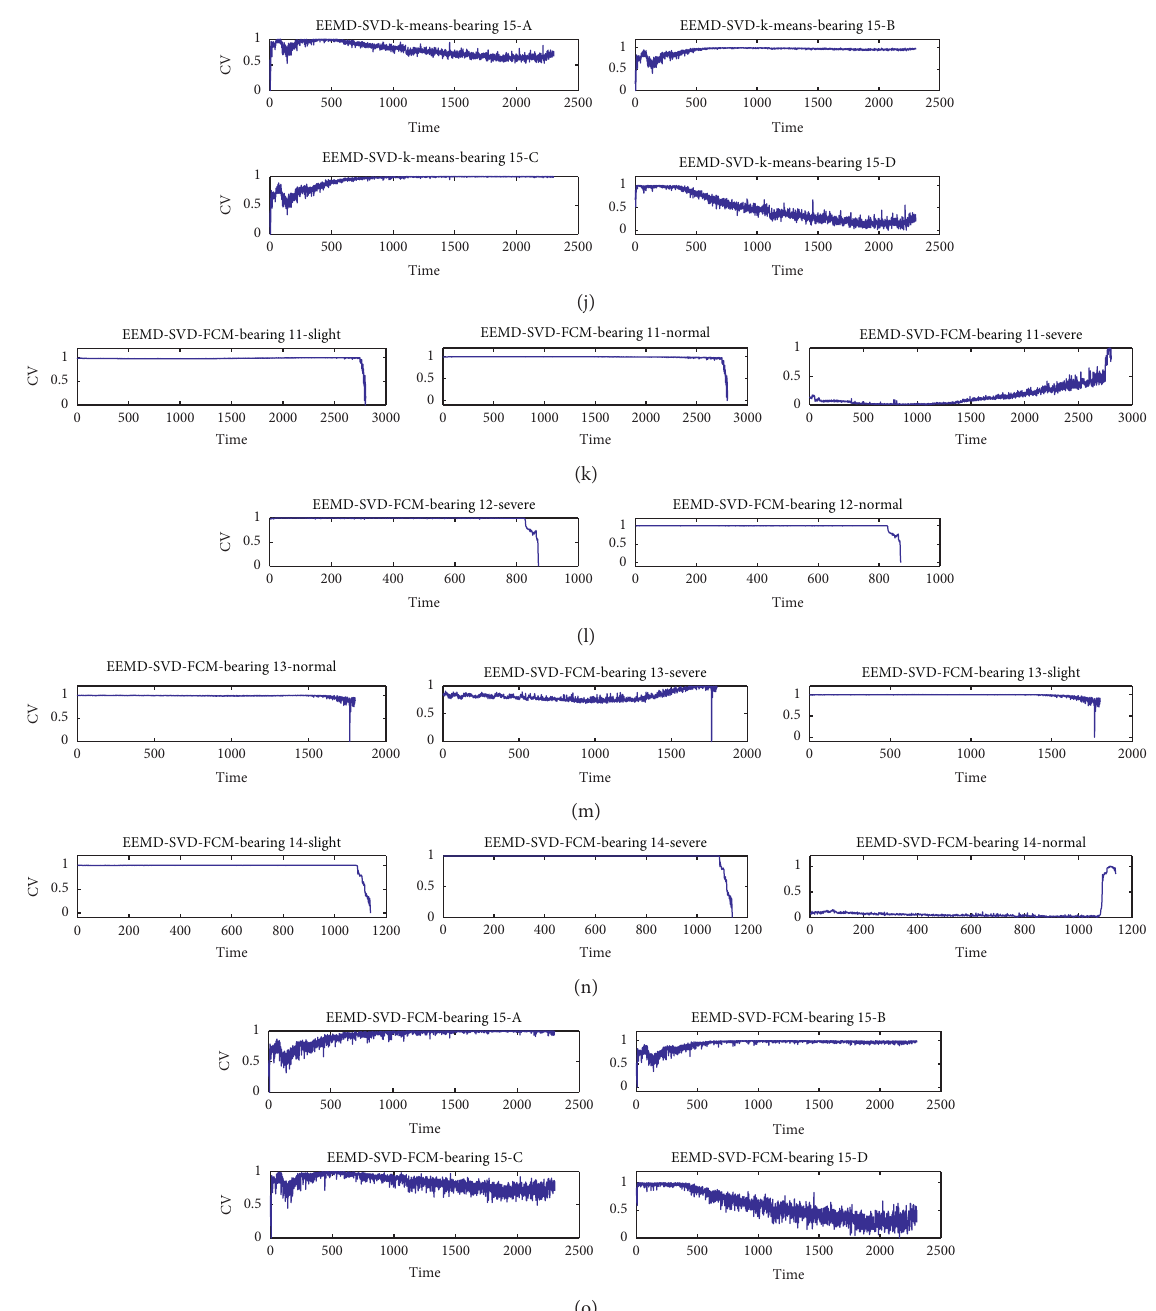
Figure 26: CVs for bearings 11–15 obtained from EEMD-SVD-k-medoids/k-Mean/FCM under various conditions such as “Normal,” “Slight,” and